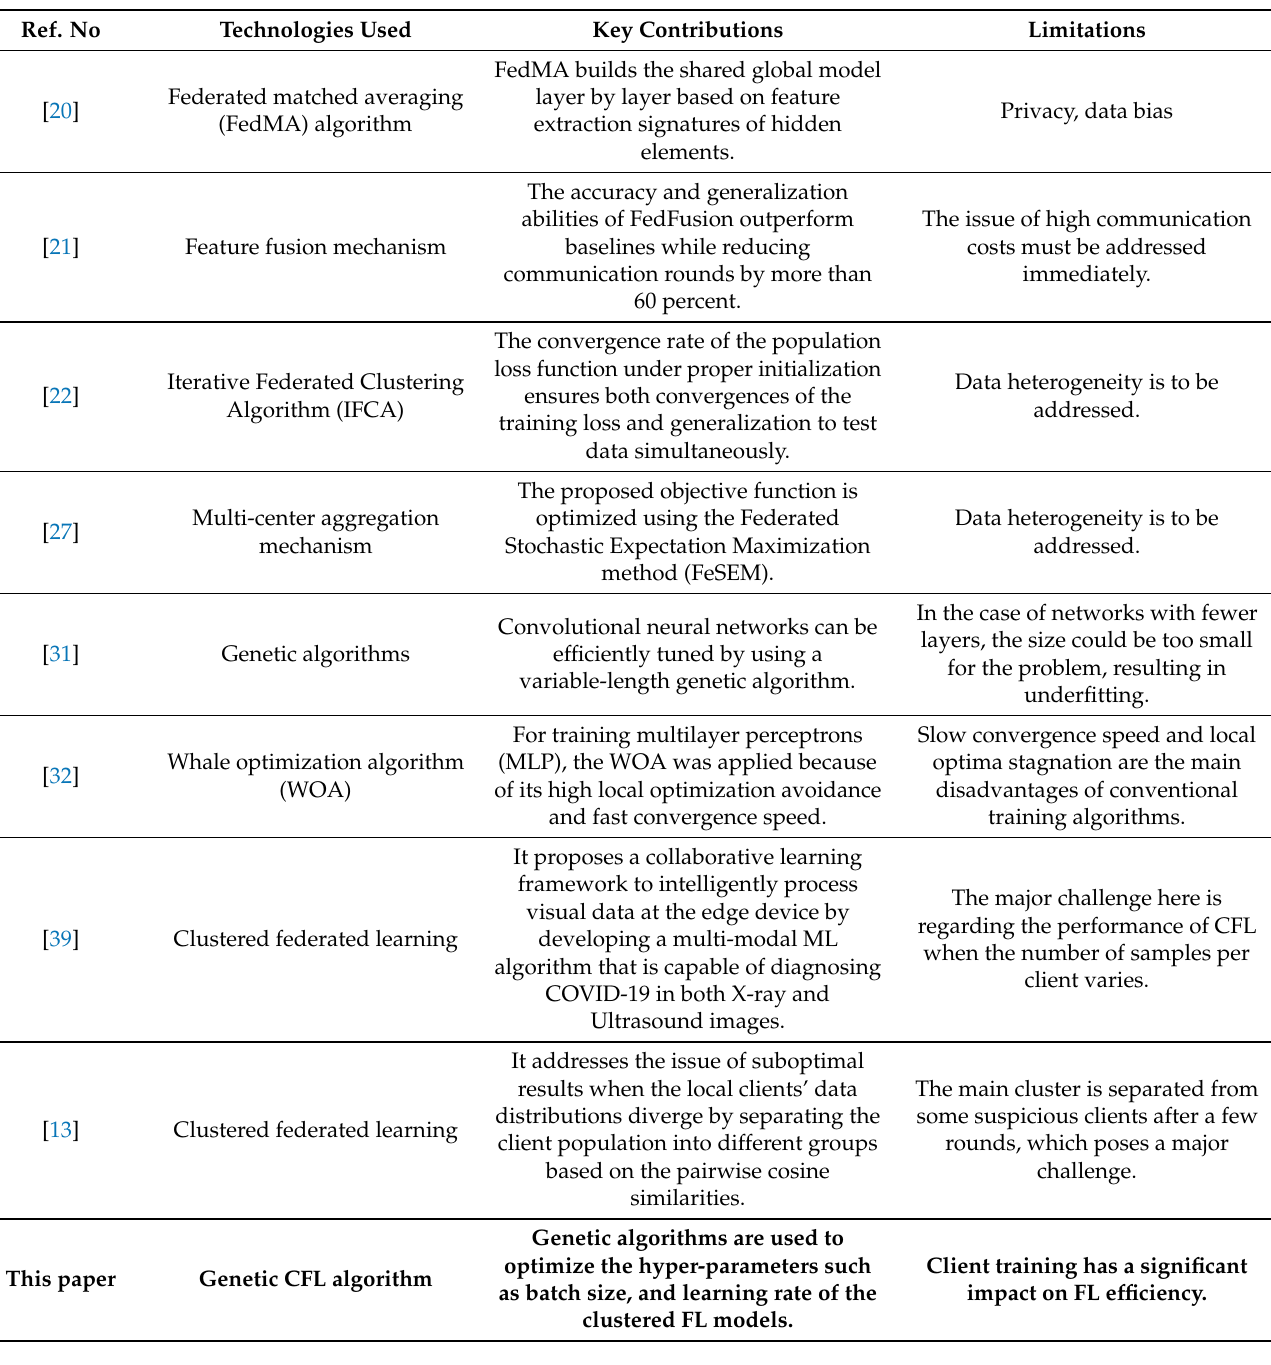
Table 1. Summary of important surveys on FL and rvolutionary